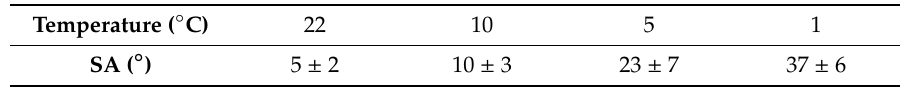
Table 2. SA of nano / microsilica-filled A-PDMS-modified epoxy coating ( R n / m = 8:2) at various temperatures (average with ± one standard